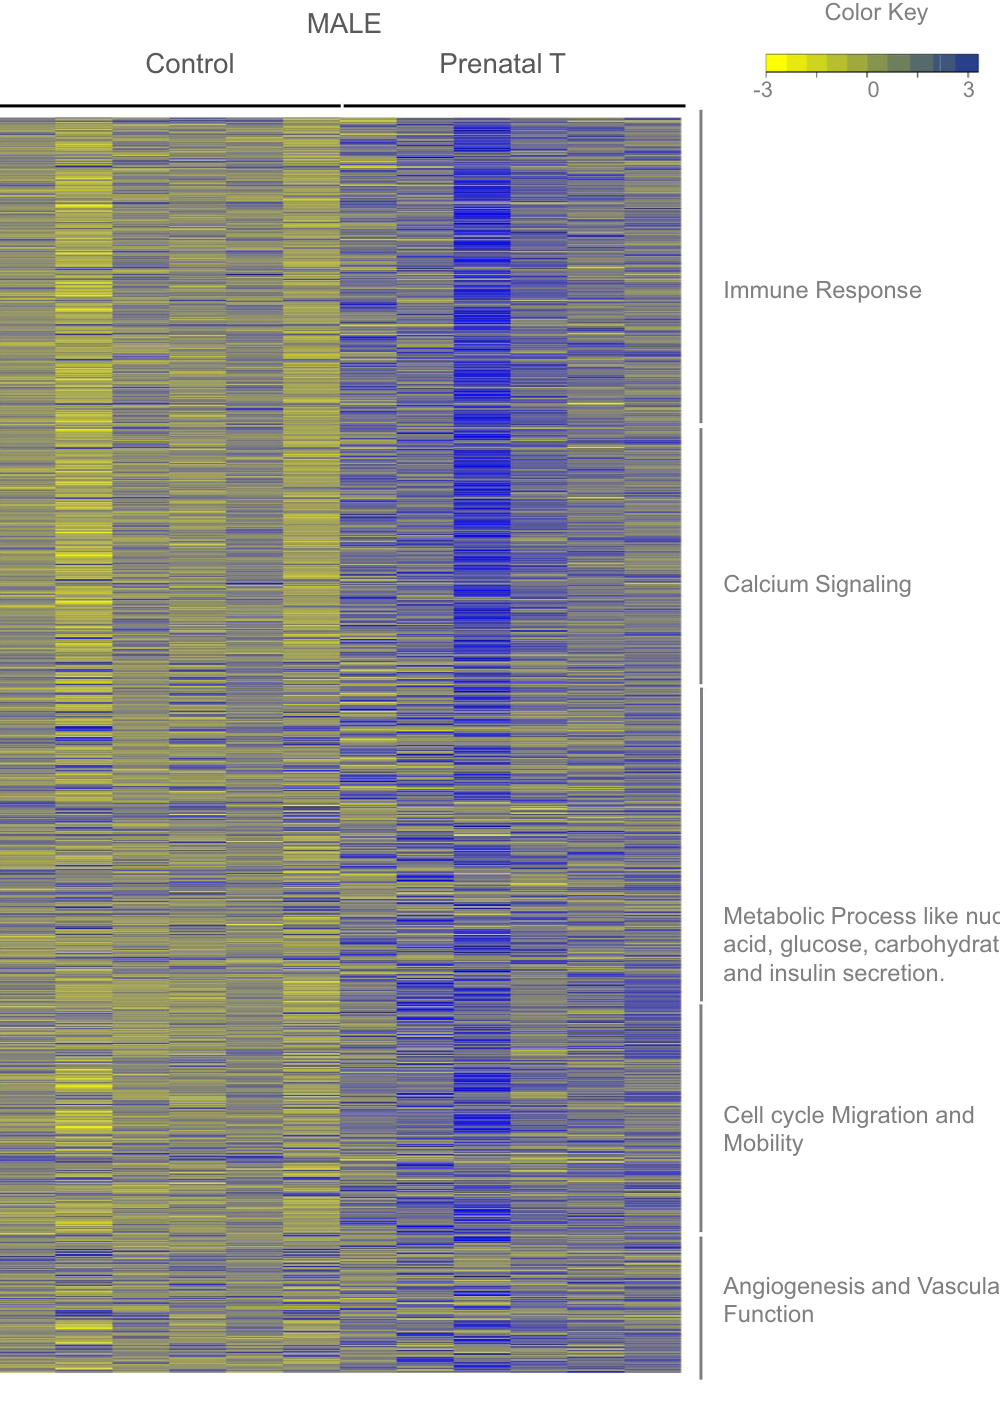
Figure 6. Expression Levels of Genes in Dysregulated Pathways Unique to Male Fetal Cardiac Tissue in Response to prenatal T. Heatmap showing genes involved in the pathways representing selected pathways that is dysregulated uniquely in male (C = 6, T = 6). The genes associated with the gene pathway in controls animals and prenatal-T treated animals are plotted along a gradient of colors, with blue representing highest and yellow the lowest normalized